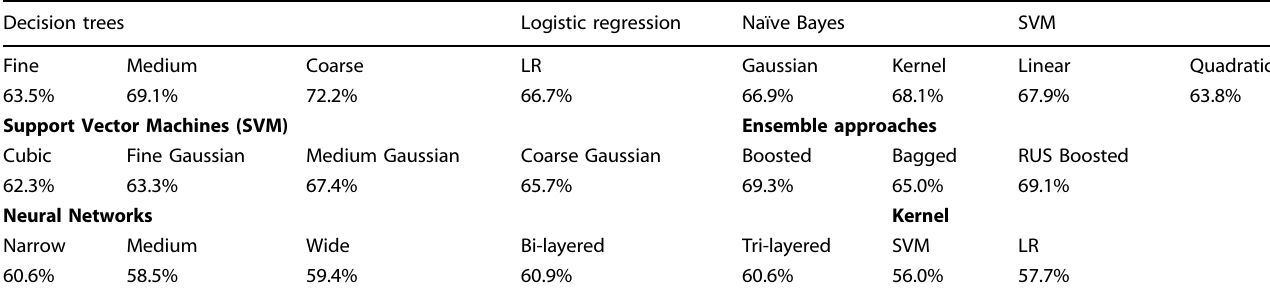
Table 5. Comparation results of 22 classi fi cation models in term of accuracy via fi ve-fold cross-validation in MATLAB “ classi fi cationLearner ” .